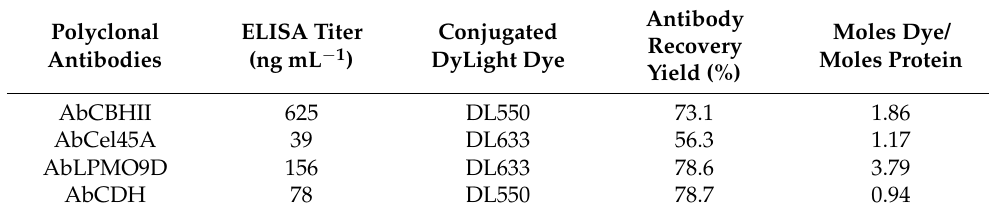
Table 2. Labeling efficiencies of rabbit polyclonal antibodies produced against P. chrysosporium hydrolases and oxidoreductases.